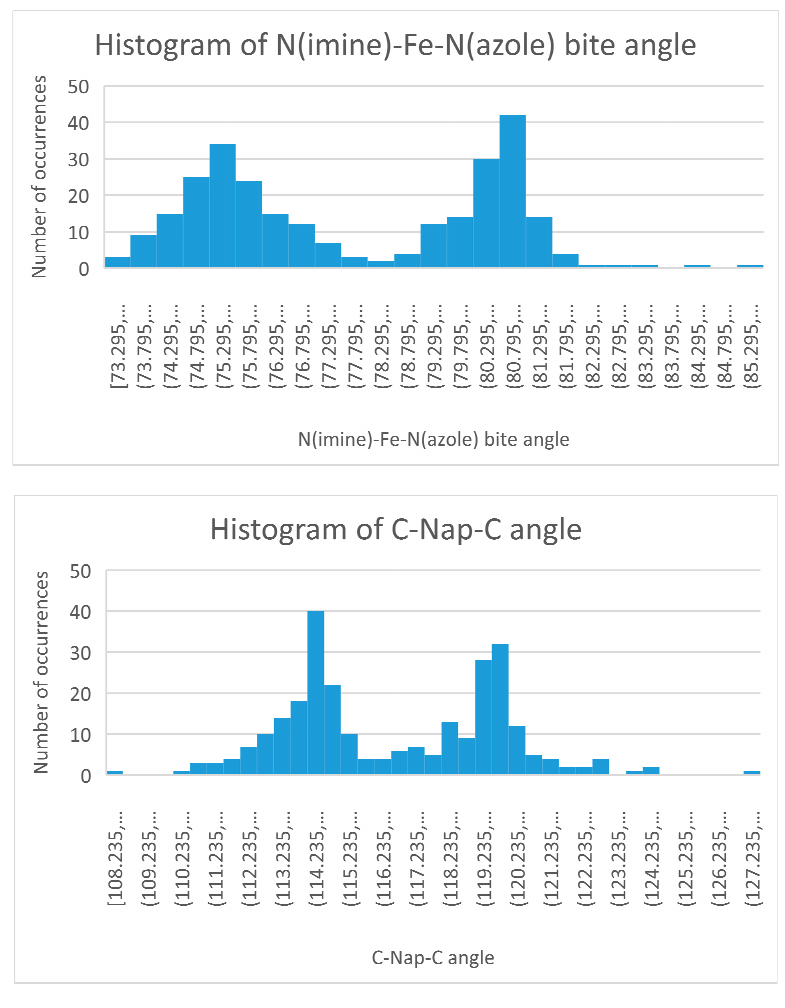
Figure 7. Histogram of the N imine -Fe(II)-N azole bite angle (top) and C-N ap -C bond angle (bottom) of 83 cationic compounds of a SB of tren condensed with a 5 membered azole carboxaldehyde. Note the bimodal distribution.